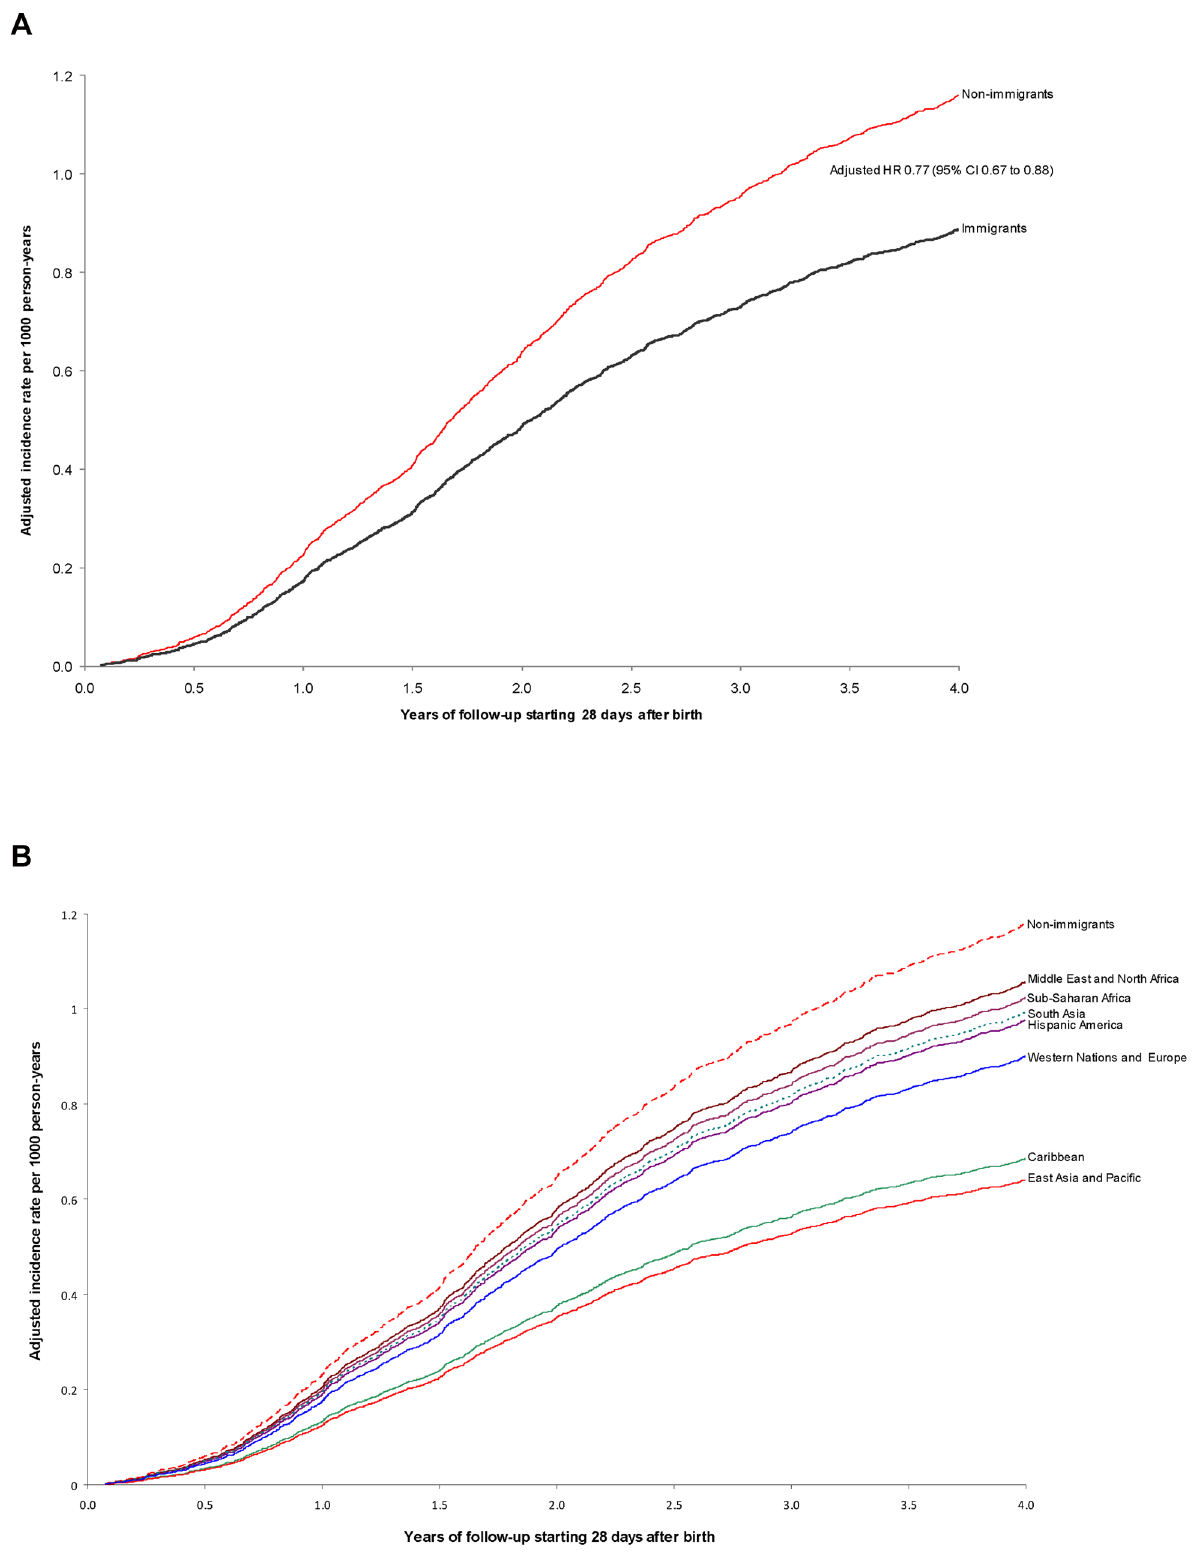
Figure 1. Risk of cerebral palsy (CP) comparing immigrants to non-immigrants (Figure 1a), as well as immigrants by World region of origin to non-immigrants (Figure 1b). All data were analyzed starting 28 days after birth, and adjusted for maternal age, parity, income quintile, any diabetes mellitus, obesity, tobacco use, Caesarean delivery, fiscal year of delivery, number of physician visits between day 1 and day 140 of pregnancy, twin pregnancy, preterm birth before 32 weeks, preterm birth from 33 to 37 weeks, small for gestational age birthweight under the 10th percentile, and large for gestational age birthweight over 90th percentile. doi:10.1371/journal.pone.0102275.g001 PLOS ONE | www.plosone.org